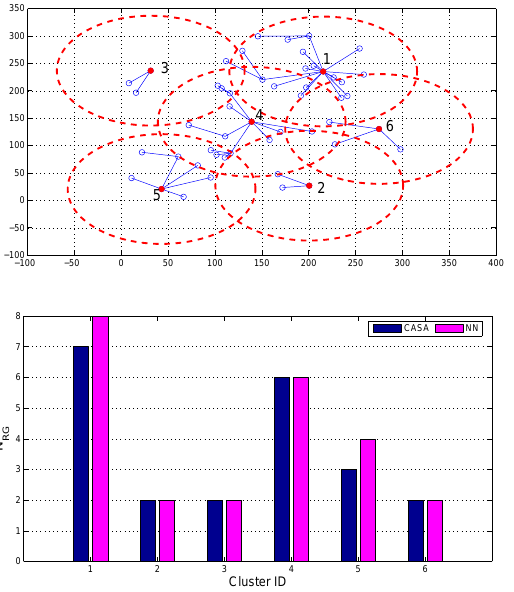
Figure 20. The coverage percentage of the whole network and each cluster (the top-right quadrant); the accuracy of the neural network architecture (the bottom-left quadrant) and the accuracy of the Probabilistic Model (PM) in a random network (the bottom-right